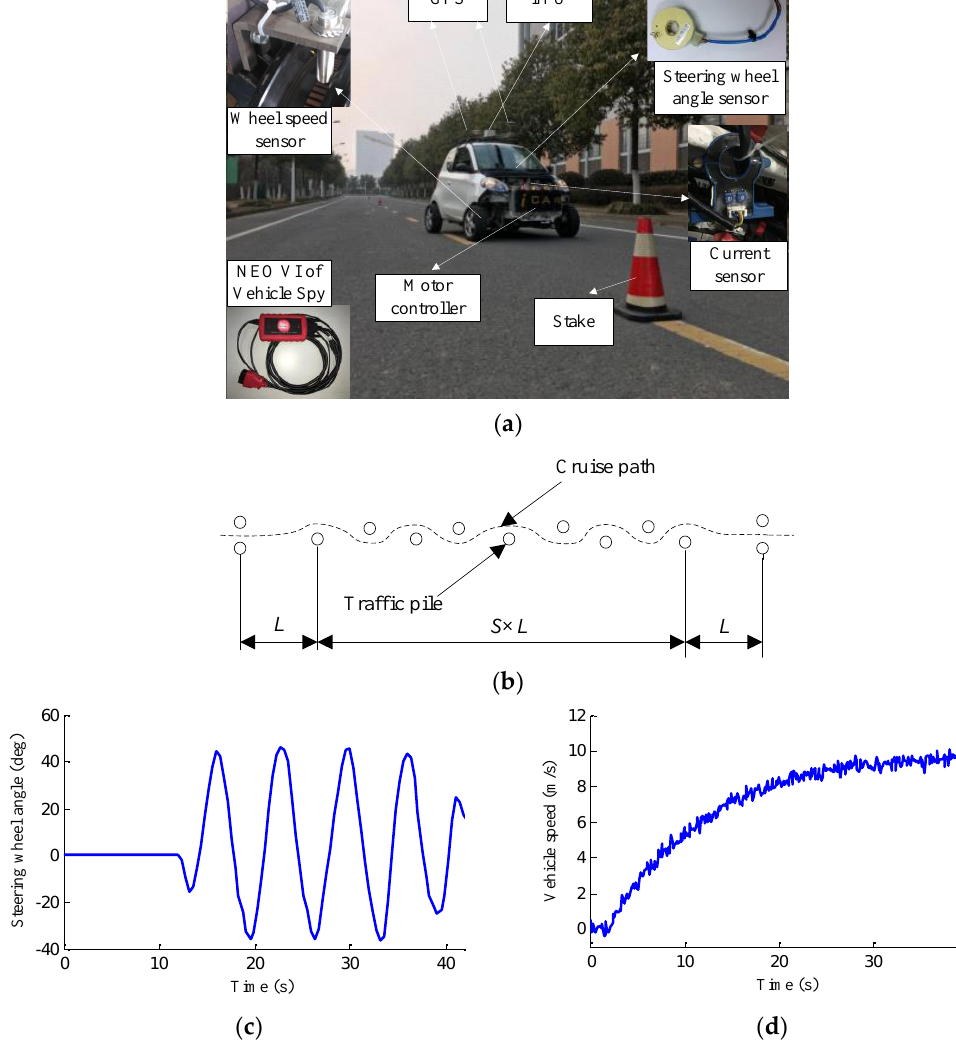
Figure 21. Road test. ( a ) 4WID-EV and experimental scene; ( b ) Vehicle trajectory; ( c ) Steering wheel angle; ( d ) Vehicle speed.